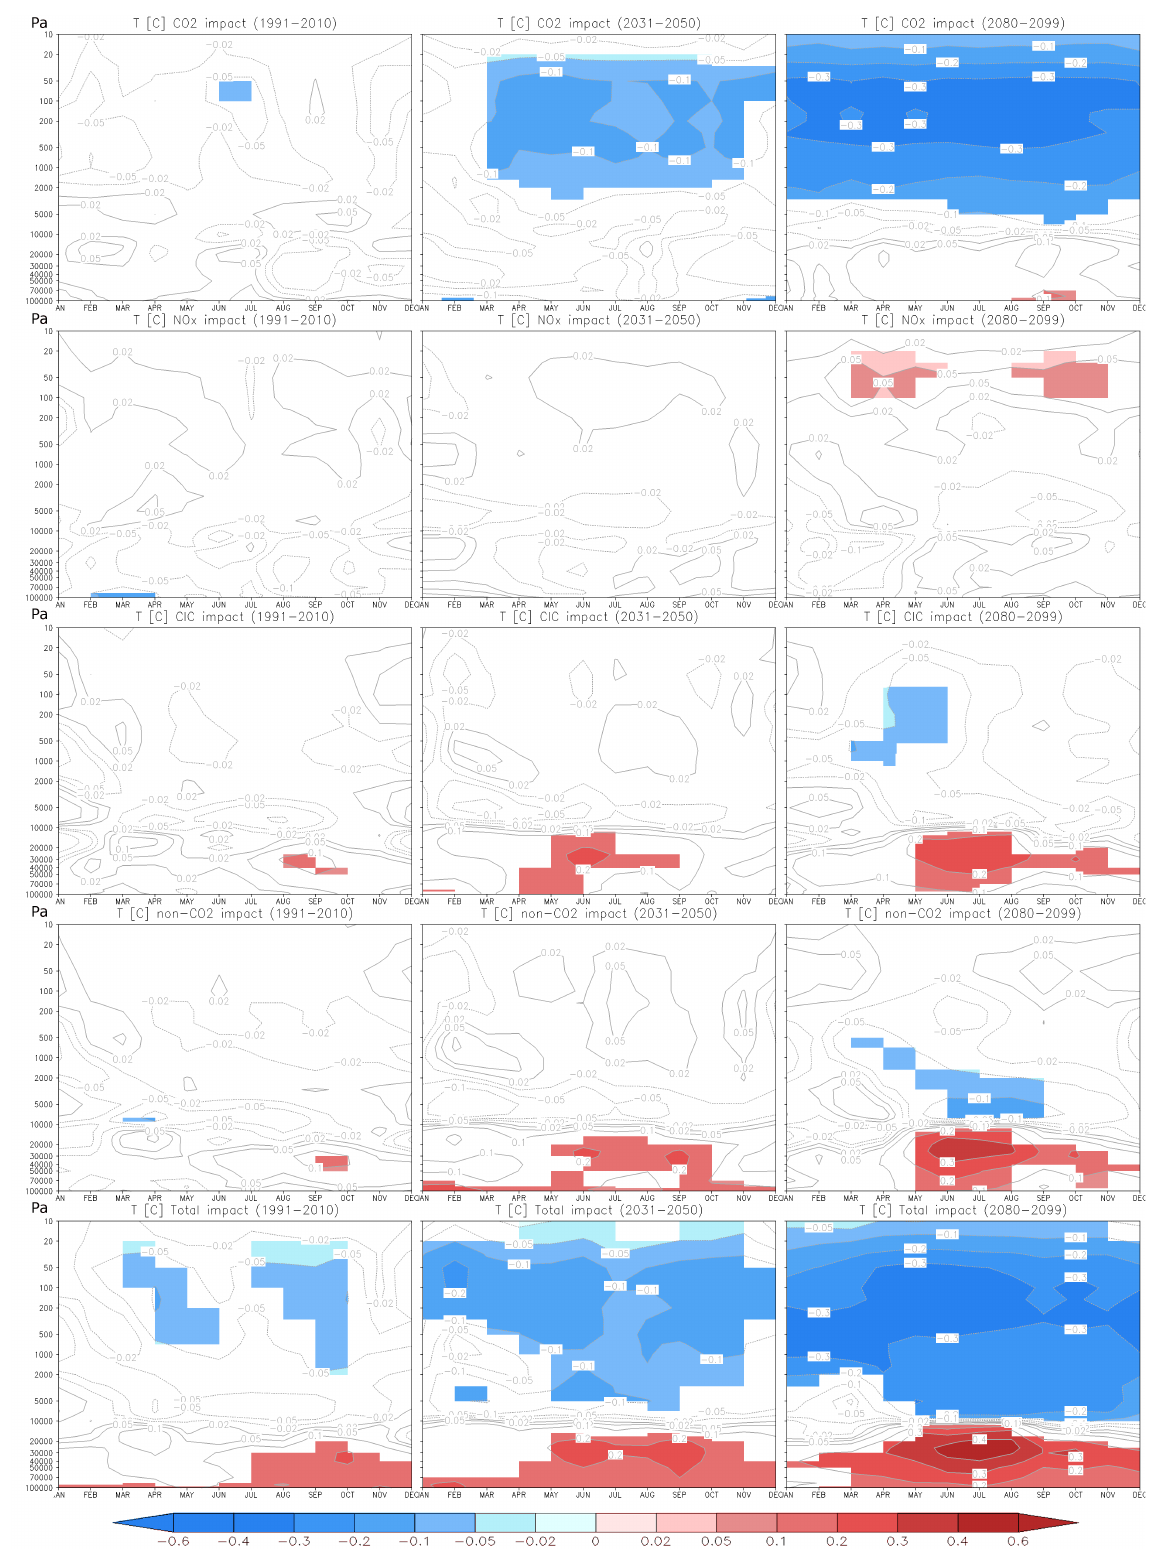
Fig. 12. Impact on the monthly global vertical profile of temperature due to aviation emissions averaged over 1991–2010 (left column), 2031–2050 (middle column) and 2080–2099 (right column). The rows represent the impact of CO 2 and NO x emissions, of CIC, of the non-CO 2 emissions and of all the emissions considered (Total impact). The shaded areas represent statistically significant changes at the 95% level of confidence when applying a t-test. The vertical axis corresponds to pressure in